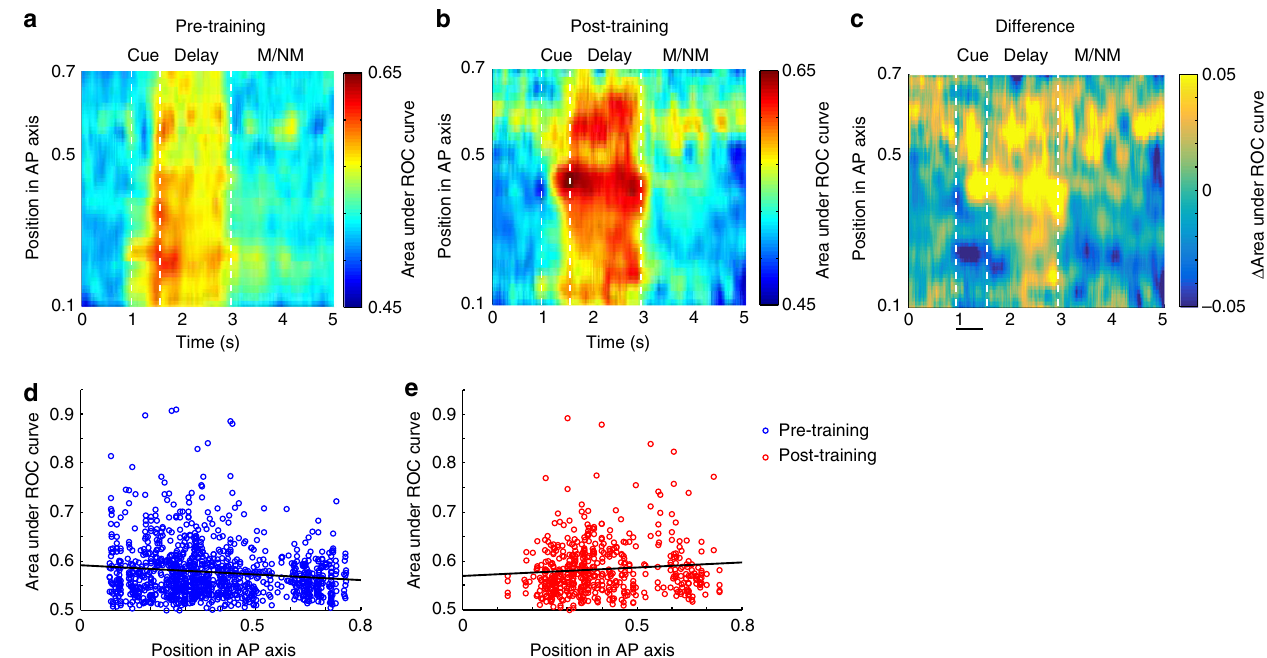
Fig. 4 Receiver operating characteristic analysis. a , b ROC values are plotted along the Anterior-Posterior axis of the dorsal prefrontal cortex before and after training ( n = 3040). Each ROC value was obtained in a 250 ms bin across time, and at across the AP axis, and then smoothed with a Gaussian. Cue presentation is indicated between horizontal lines spanning the time interval of 1.0 – 1.5 s in the plot. First delay period spans the interval of 1.5 – 3.0 s. This is followed by the sample stimulus (both match and nonmatch pooled together). c Difference of pre- and post-training stages. d Each point represents the mean ROC value of the 250 ms bins tiling the delay period of each individual neuron, prior to training. Line represents linear regression. e ROC values of each neuron, during the delay period, in recordings obtained after training. Total sample size, n = 3040